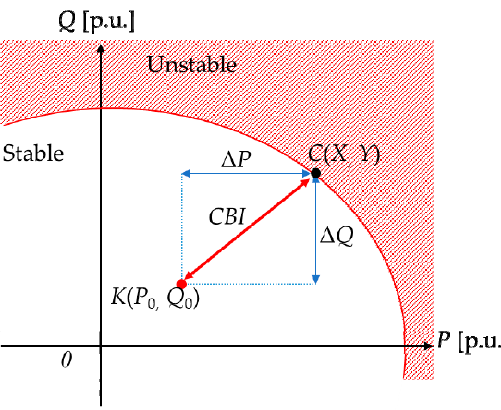
Figure 2. Critical boundary of the voltage stability in P-Q characteristics.